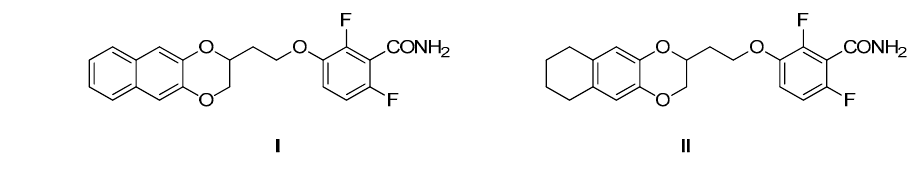
Figure 1. Structures of PC190723 , derivatives I and II.